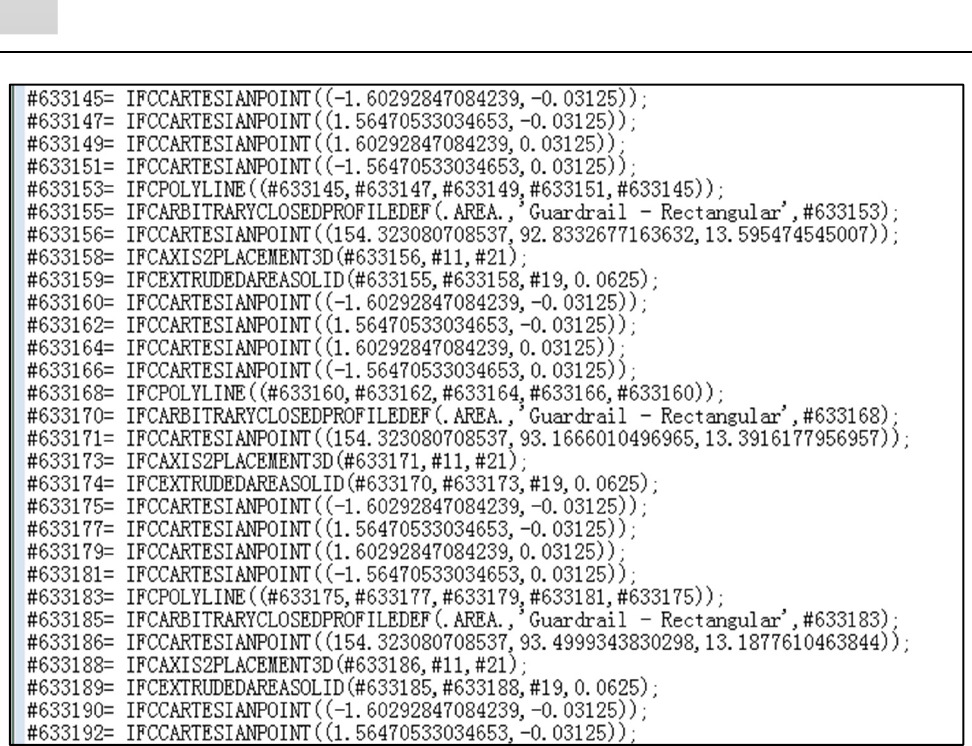
Figure 1. ETDI model TXT display.